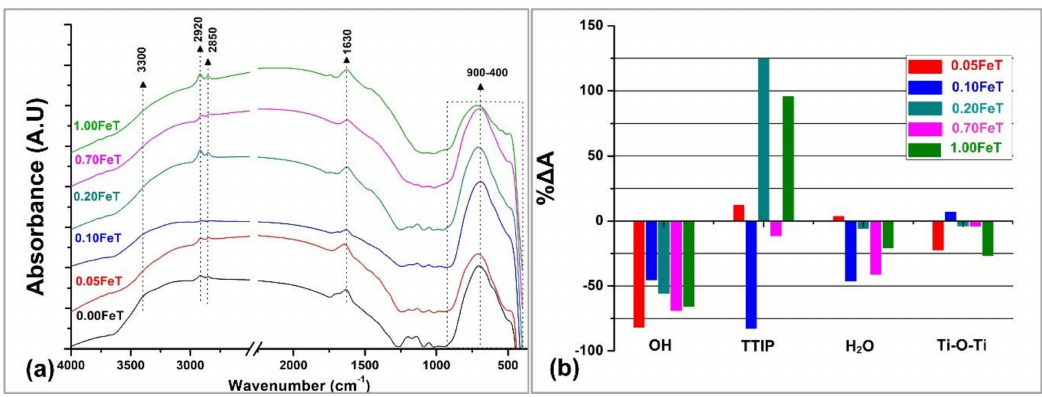
Figure 1. FTIR spectra ( a ) of the synthesized photoactive Fe-TiO 2 nanoparticles along with the undoped TiO 2 sample (0.00FeT) and ( b ) % di ff erence of the integrated areas, ∆ A: 3300 (OH), 2920–2850 (TTIP), 1630 (H 2 O), and 900–400 (TiO 2 ) cm − 1 compared with the 0.00FeT, according to Equation (2).